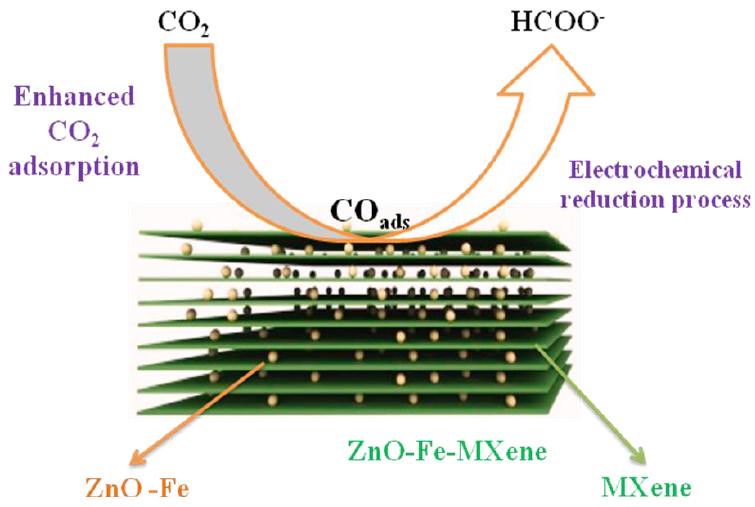
Figure 7. Reaction mechanism of the eCR on ZnO-Fe-MXene hybrids.